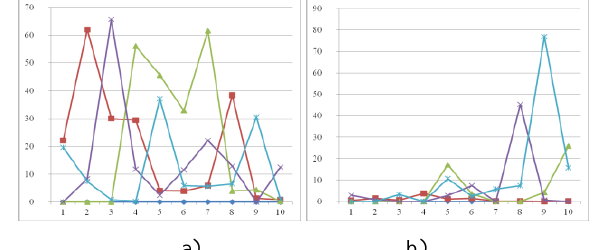
Figure 6 Additions to line data for a) commercial and b)